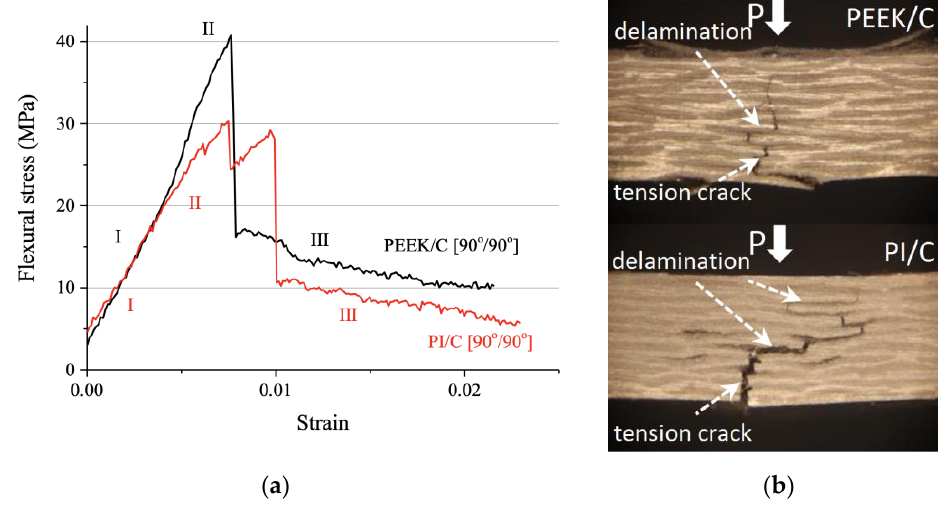
Figure 4. The flexural stress–strain curves ( a ) and optical images of the specimen cross-sections after the three-point flexural tests ( b ) for the PEEK/CF (90°/90°) and PI/CF (90°/90°)